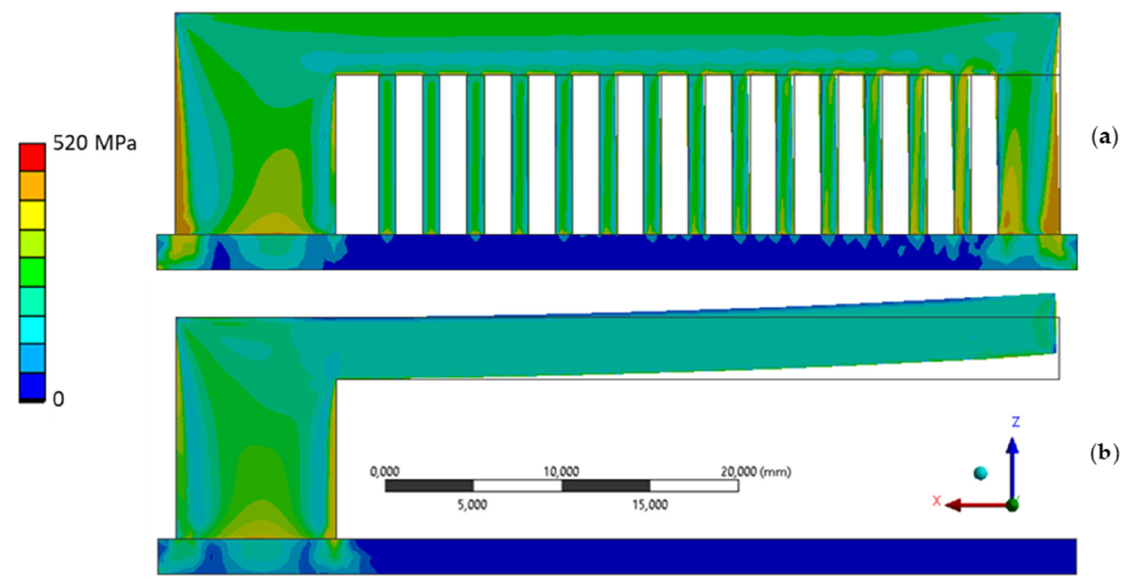
Figure 11. Simulated equivalent stress according to von Mises ( a ) before and ( b ) after the removal of the support material.